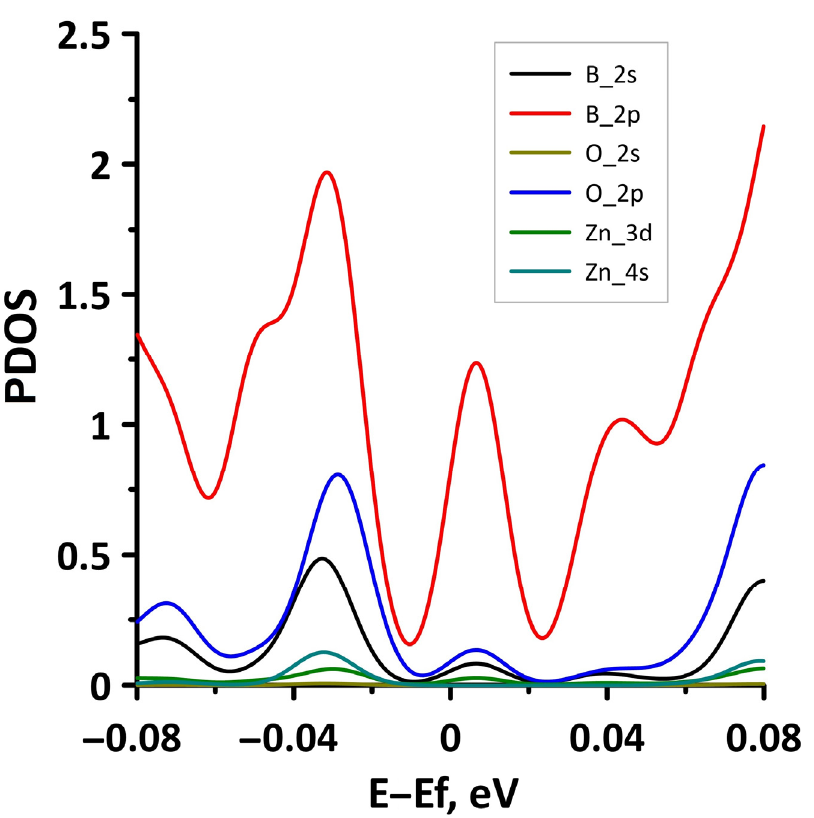
Figure 14. Fragments of PDOS near the Fermi level (shifted to 0 eV) of borophene/ZnO heterostruc- ture under uniaxial stretching by 14%.